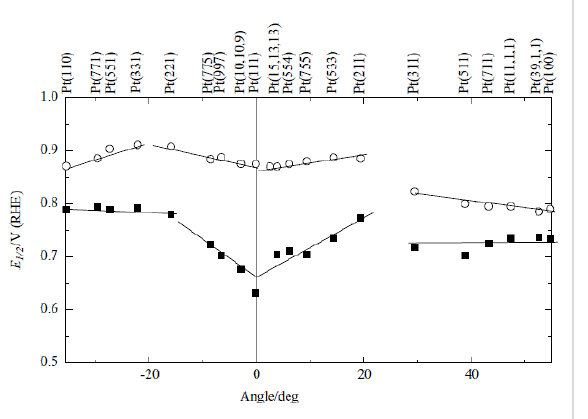
Figure 5: Plot of the half-height potential, E 1/2 , for the oxygen reduc- tion as a function of the angle of the surface with respect to Pt single crystals, basal planes and stepped surfaces, in 0.5 M H 2 SO 4 (filled squares) and 0.1 M HClO 4 (open circles) [17,23].